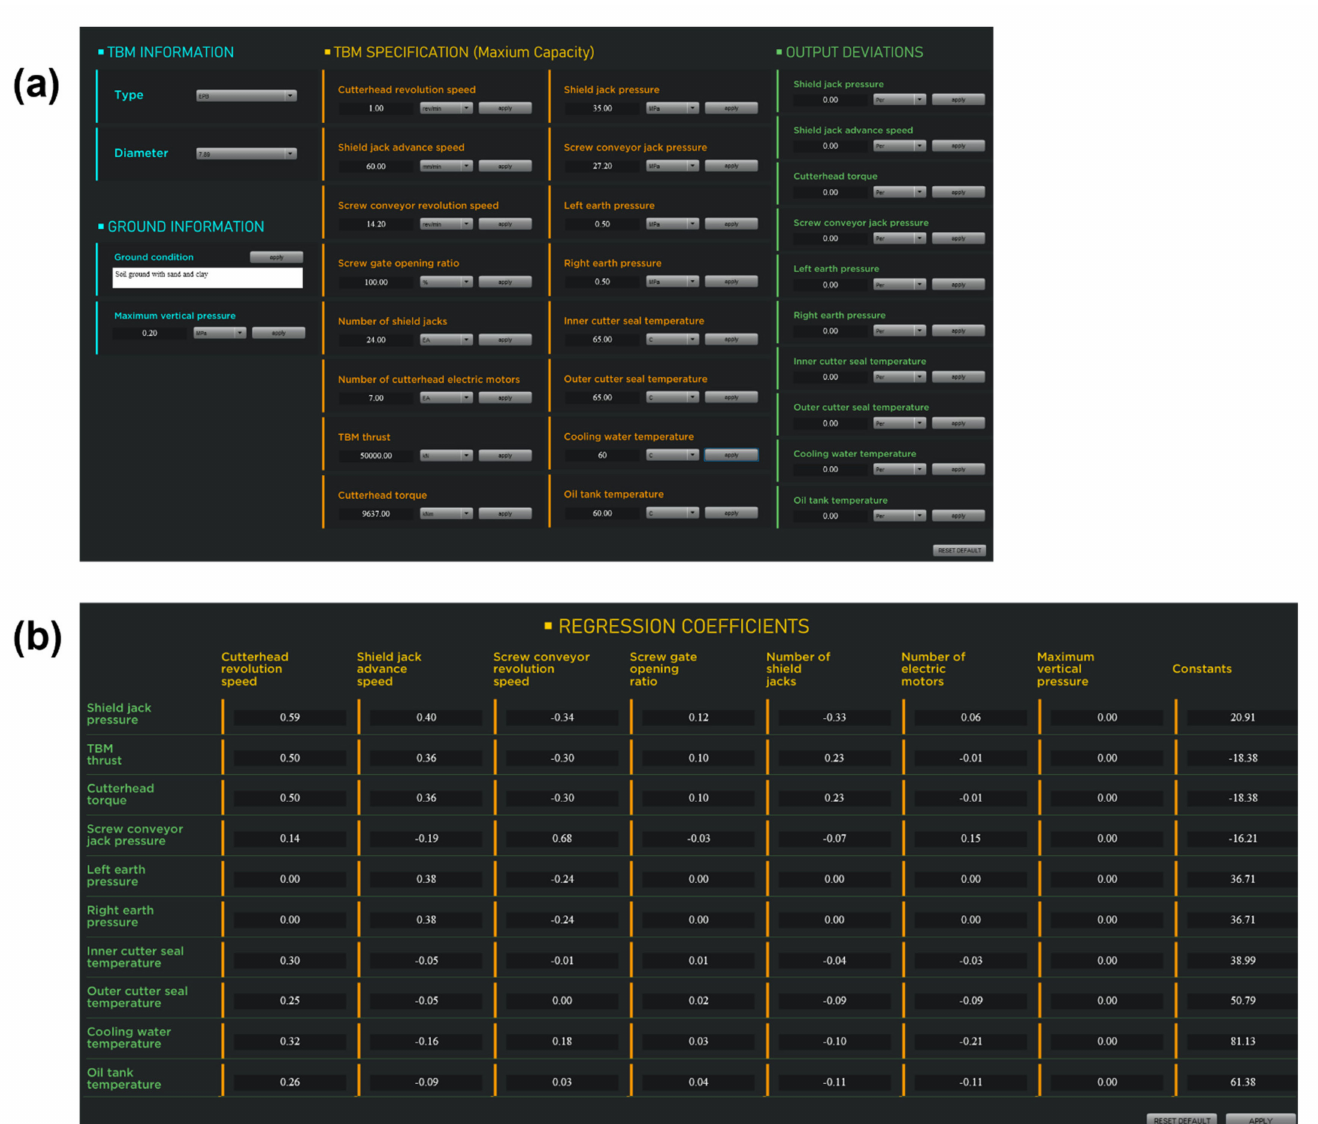
Figure 11. Pre-setting values for: ( a ) ground conditions, TBM specifications, and mechanical vibration; ( b ) coefficients of variables in each multiple regression